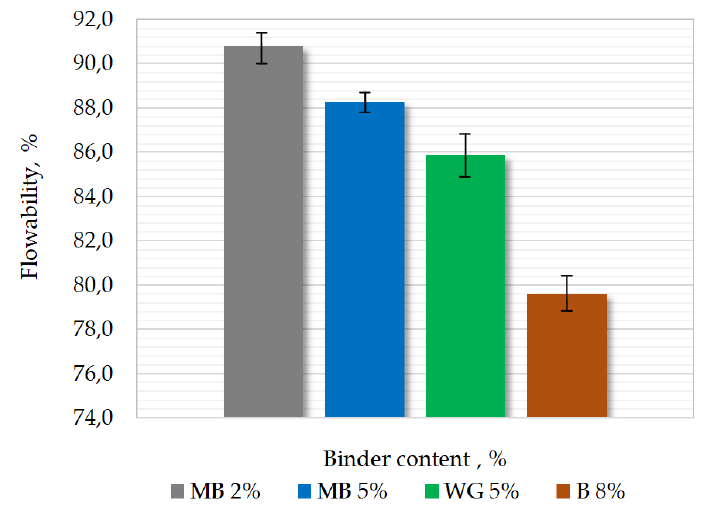
Figure 7. Results of flowability measurements of molding sands with different binders.